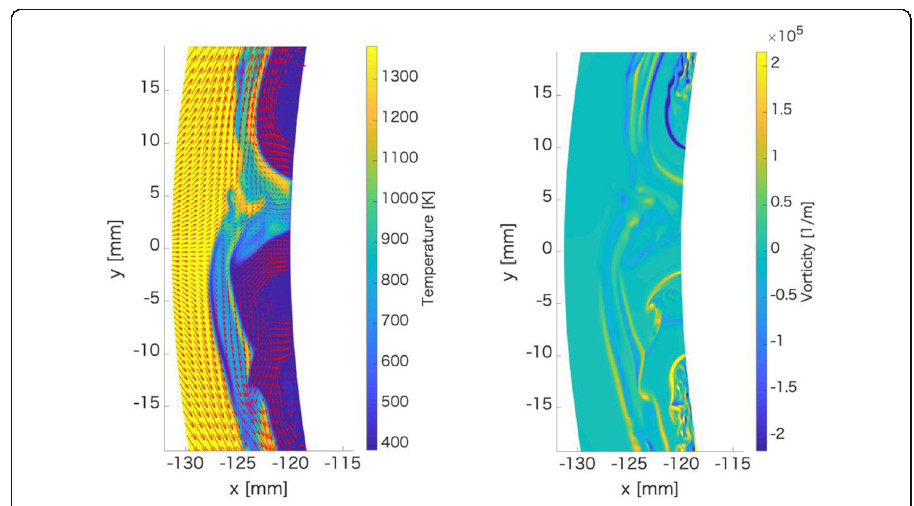
Fig. 8 Snapshots of the temperature (left) and spanwise vorticity (right) fields in the longitudinal cross section z = 5 mm (Point A). The projections of the velocity vectors on to the plane are also